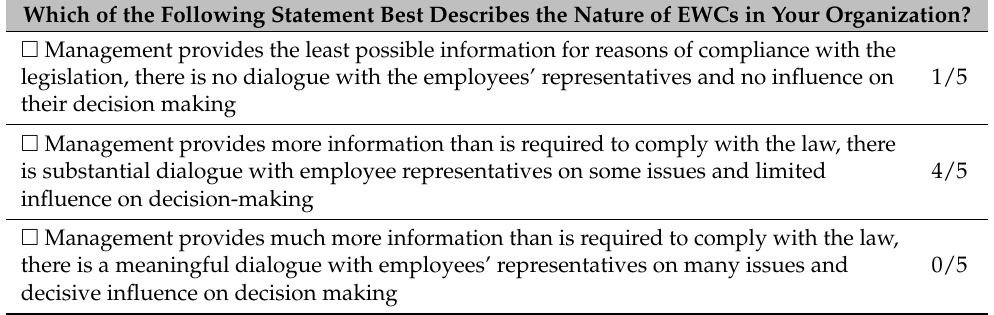
Table 11. The Nature of EWC’s in the Organization.